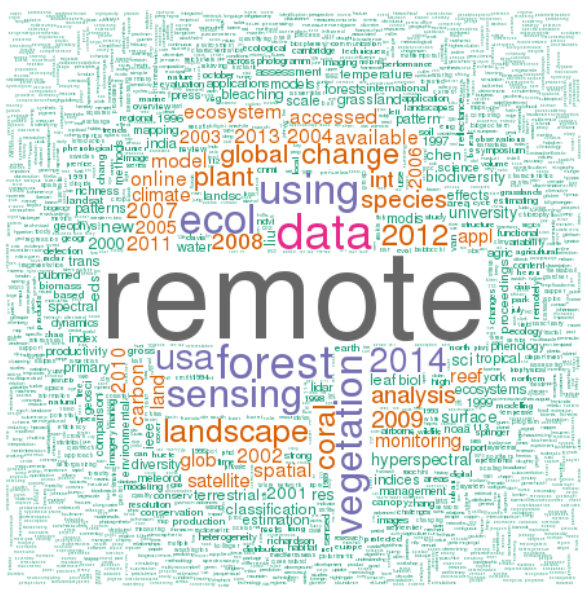
Figure 3. Cloud of the words contained in the references of the papers of the special issue “Earth Observation for Ecosystems Monitoring in Space and Time”. The bigger the size, the higher the frequency of each word. The code and the set needed to produce the cloud are available in the Supplementary